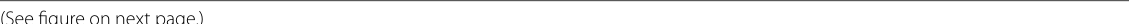
figure on next Fig. 3 Predicted heights and time intervals for Karachi tides of October–December 1945 (Additional file 2: Additional file 4: Table S3). The tides are grouped into two sets of high tides and two sets of low tides. Successive tides in each set are one lunar day (24 h 50 min) apart on average. a Heights through spring tides (moon new or full) and neap tides (quarter moons). Moon phases from Reingold and Dershowitz (2002, p 92). b Time intervals between successive tides expressed as deviations from one mean lunar